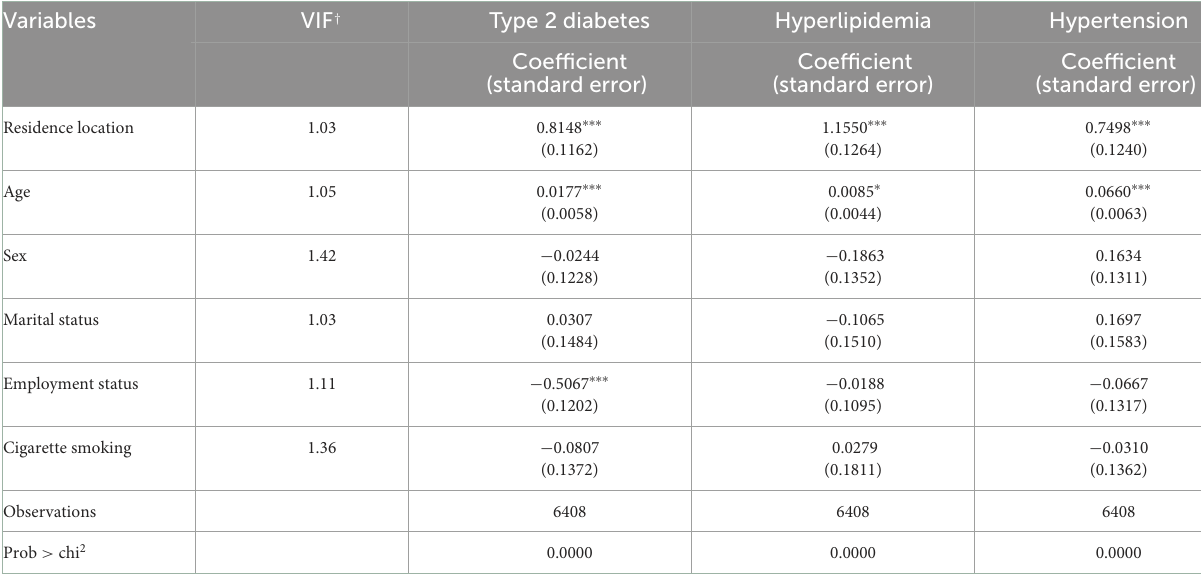
TABLE 2 The association of urban living with chronic diseases.